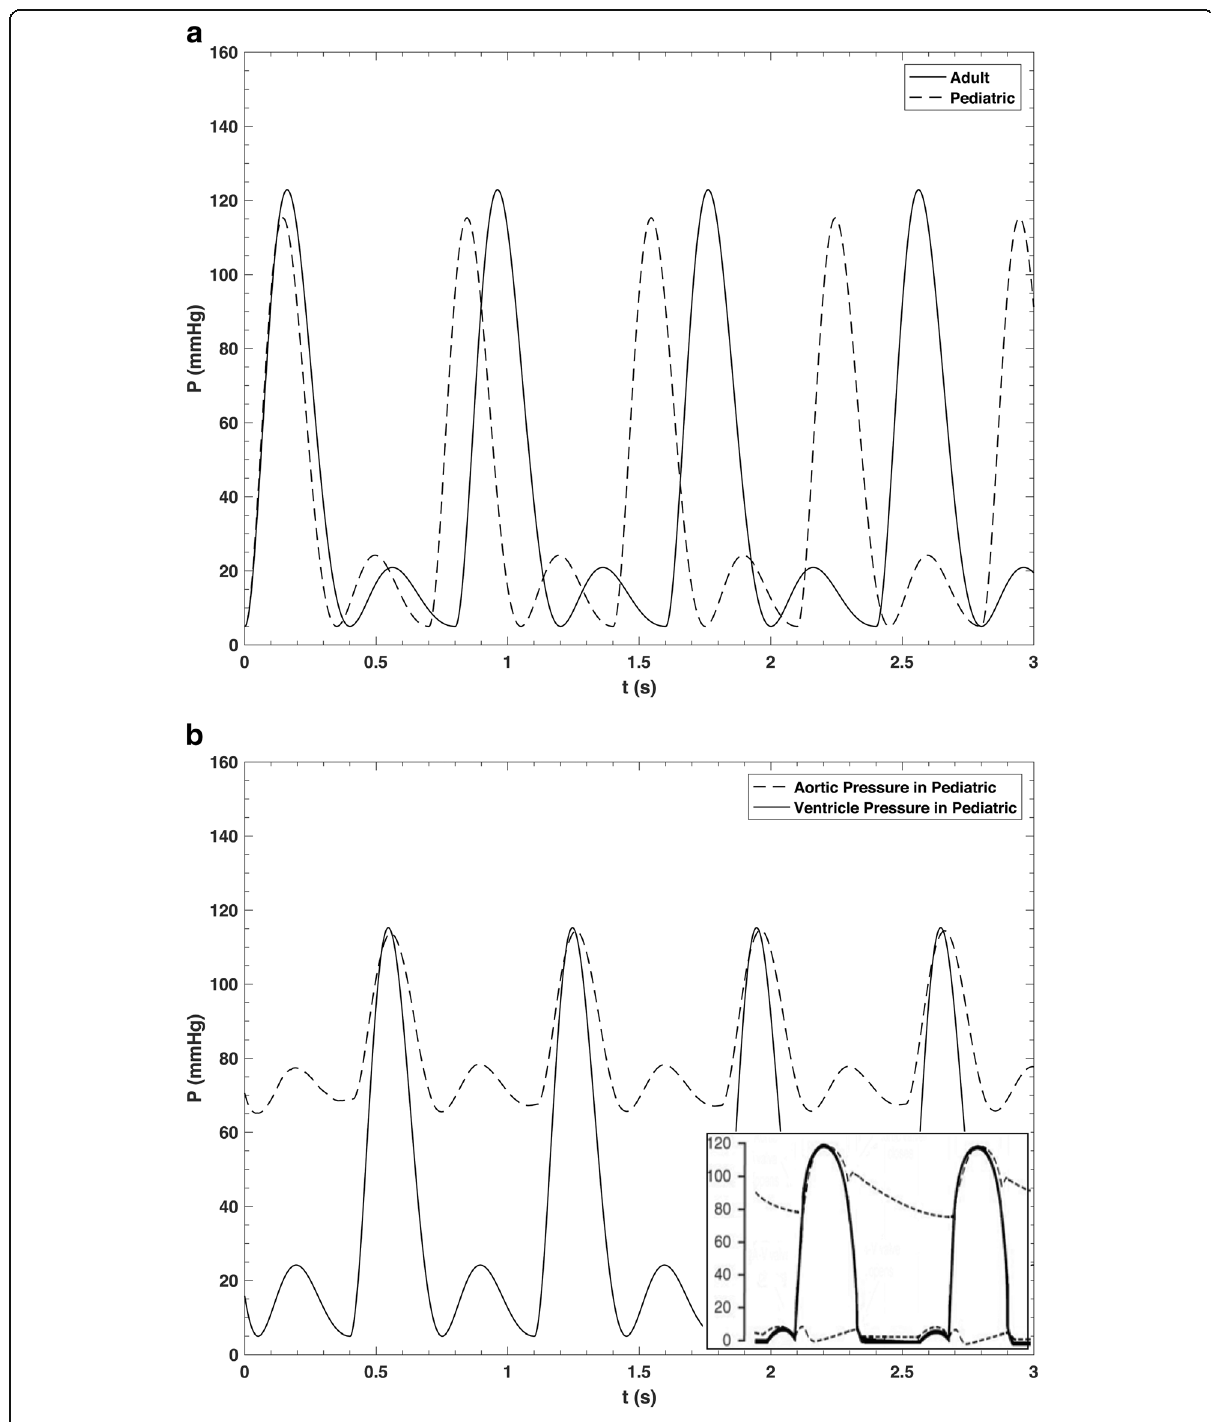
Fig. 1 The simulated cardiac pressure waveform. a Comparison of the aortic and ventricle pressure wave in paediatric. b Comparison of the ventricle pressure wave in paediatric and adult. The inset shows the physiological